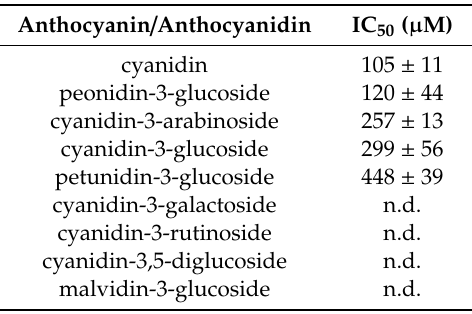
Table 4. Half-maximal inhibitory concentrations (IC 50 ) of cyanidin and anthocyanins (ACs). Results are presented as means ± SD ( n = 3–4). n.d. = not determined due to weak inhibitory e ff